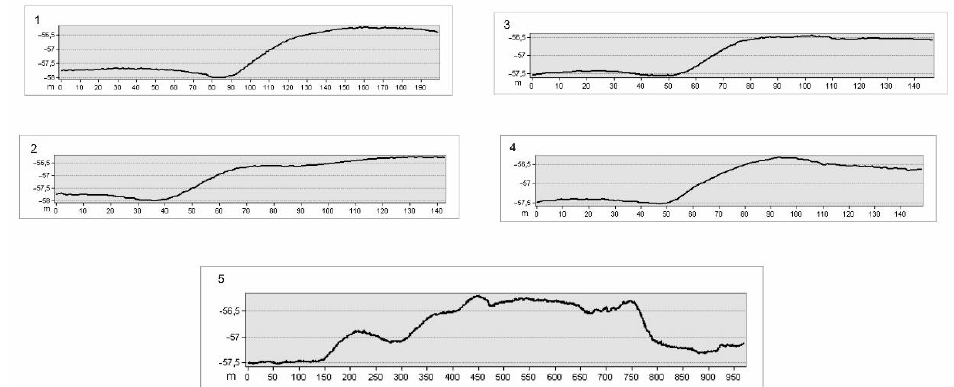
Figure 15. Multibeam bathymetry data of Pleistocene and Holocene uplifting with the cross-section through the block (MBS profiles 1, 2, 3 and 4) and profile 5, which is parallel to the structure. The